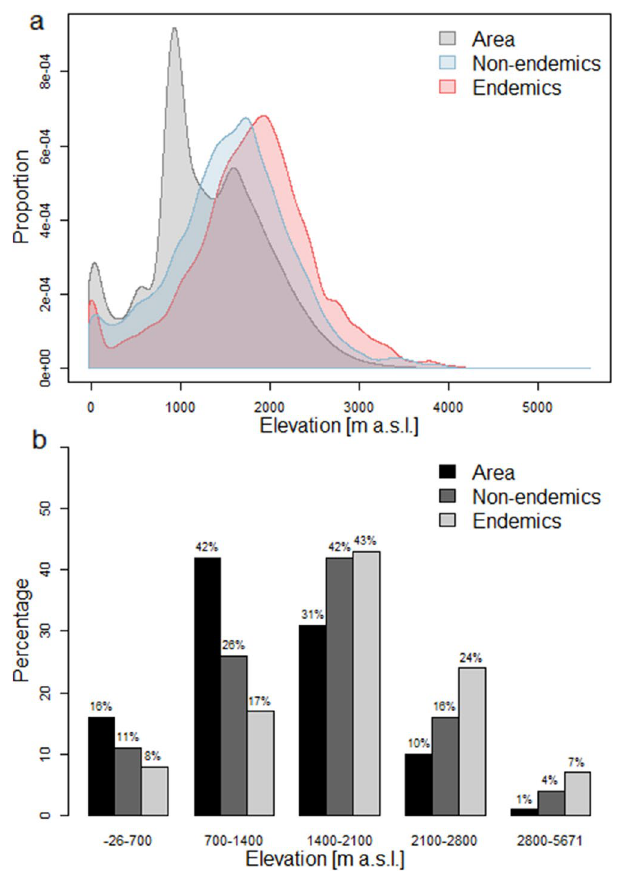
Figure 7. Elevational distribution of total endemic compared to non-endemic vascular flora of Iran. ( a ) Proportion of surface area, non-endemic and endemic species richness along the elevational gradient. ( b ) Percentage of surface area, non-endemic and endemic richness in different elevational zones.